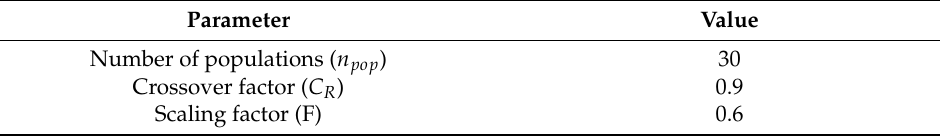
Table 2. DE parameters used for the simulation.